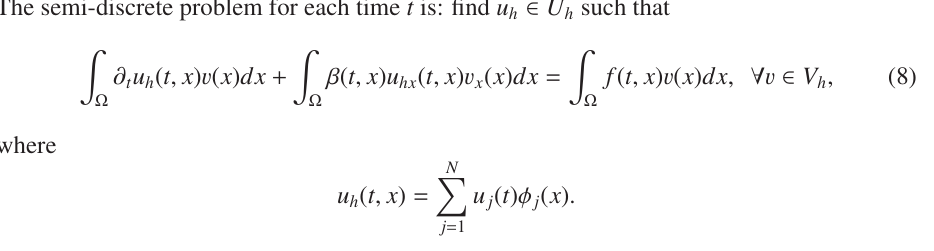
1 , 1) with β − = 1, β + = 10, and α = −